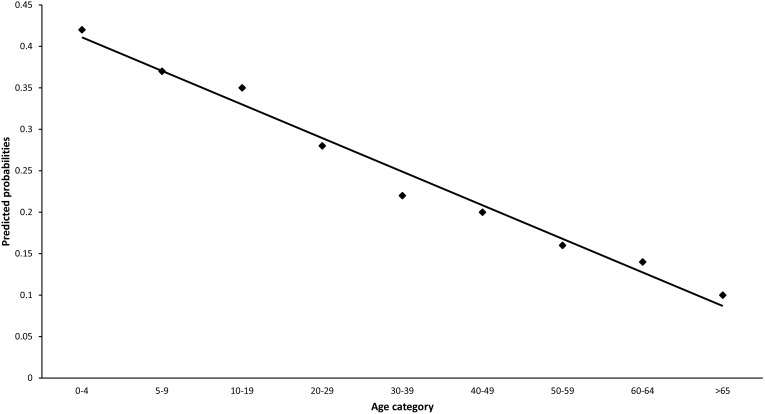
Predicted probabilities of each age group for Acute Respiratory Infections, weighted for age, sex and State or Territory of residence, Australia 2008–9.